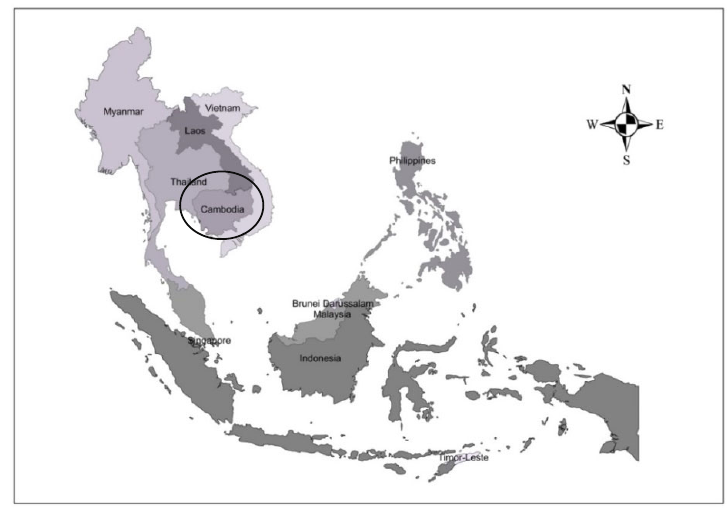
Figure 2. Map of ASEAN countries with Cambodia circled.